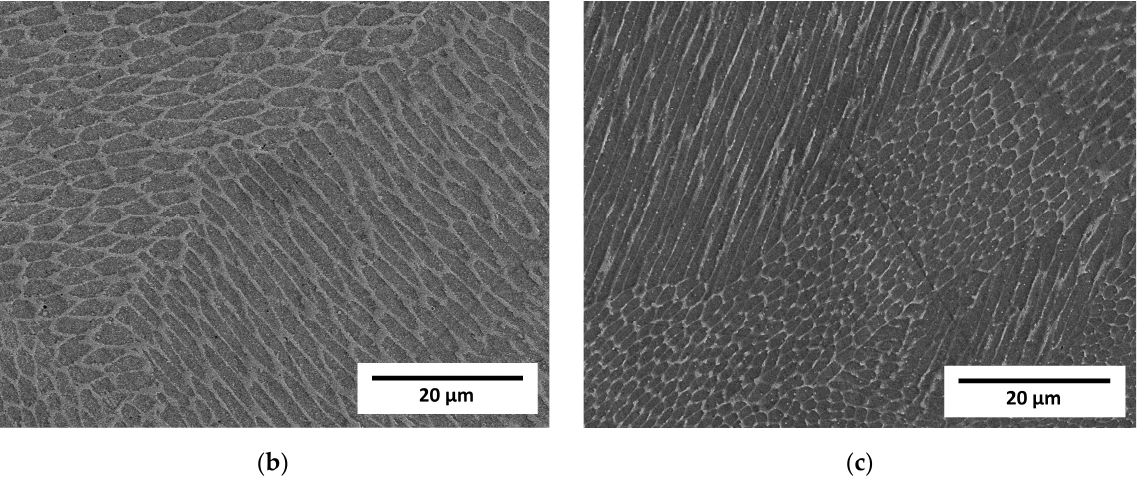
Figure 4. Micrographs of LENS ® manufactured samples taken on a scanning microscope in SE mode. ( a ) Sample A (0.7 mm layer thickness); ( b ) Sample B (0.4 mm layer thickness); ( c ) Sample C (0.2 mm layer thickness).